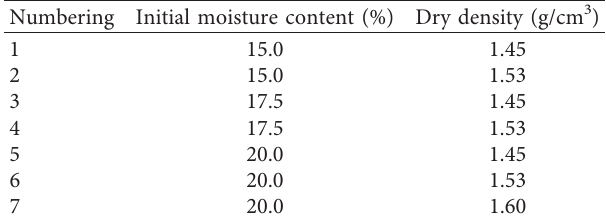
Table 1: Initial condition control of expansive